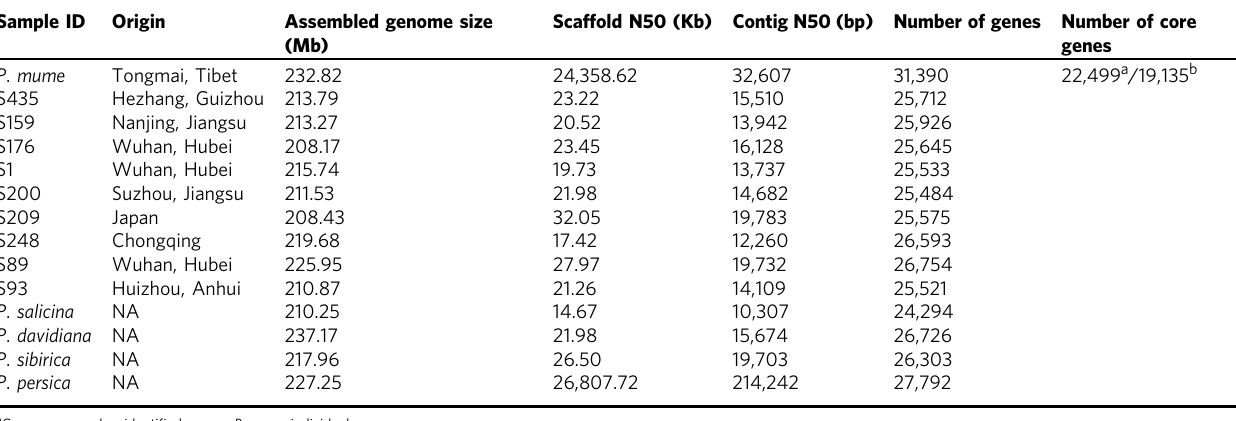
Table 1 Summary of assembly and annotation of core pan-genomes of Prunus Sample ID